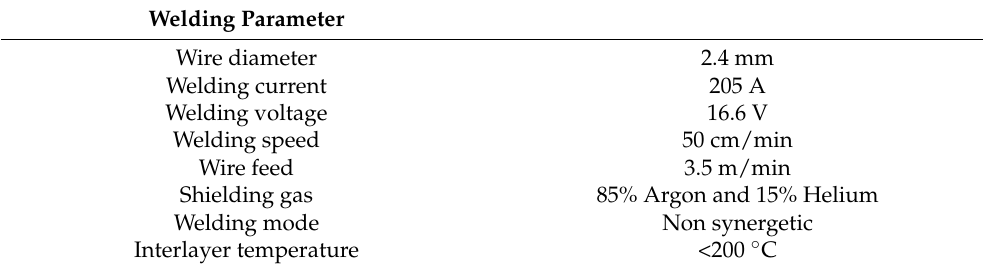
Table 2. Welding parameters.